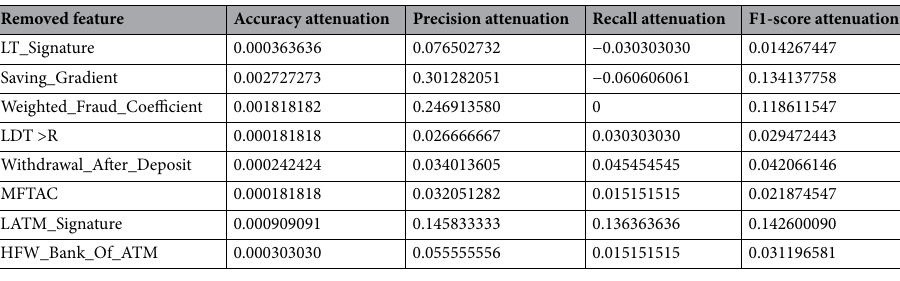
Table 4. Magnitude of performance degradation caused by removing one of the features proposed in section "Features based on atypical detection techniques".